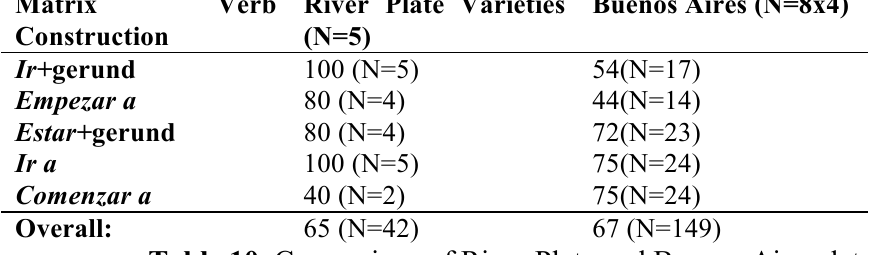
Table 10 . Comparison of River Plate and Buenos Aires